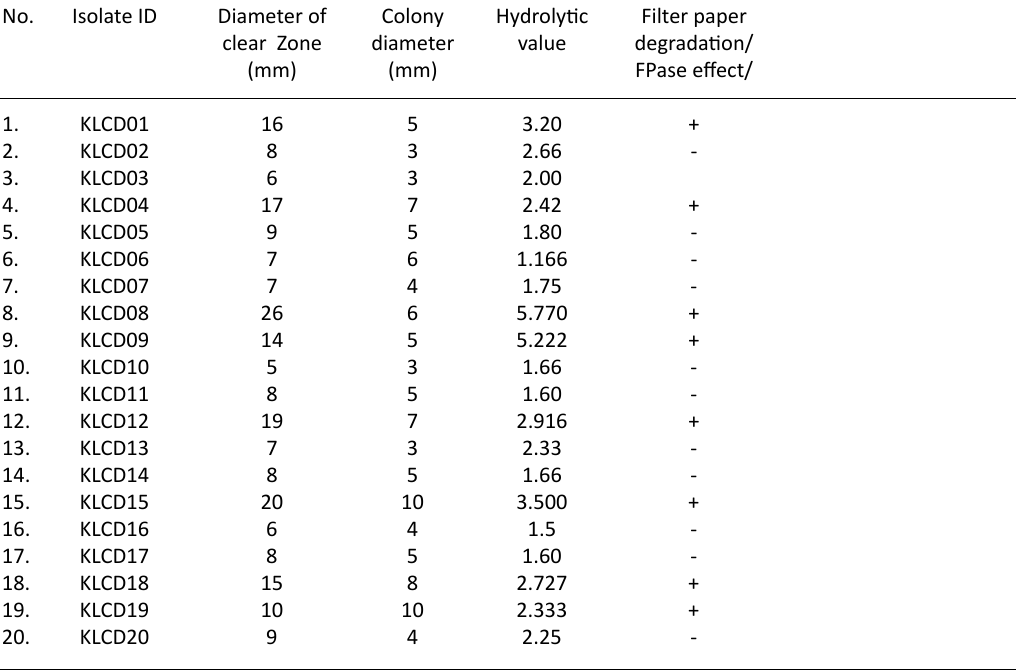
table 1. Clearance zone diameter and enzyme hydrolytic value of Cellulose degrading bacteria